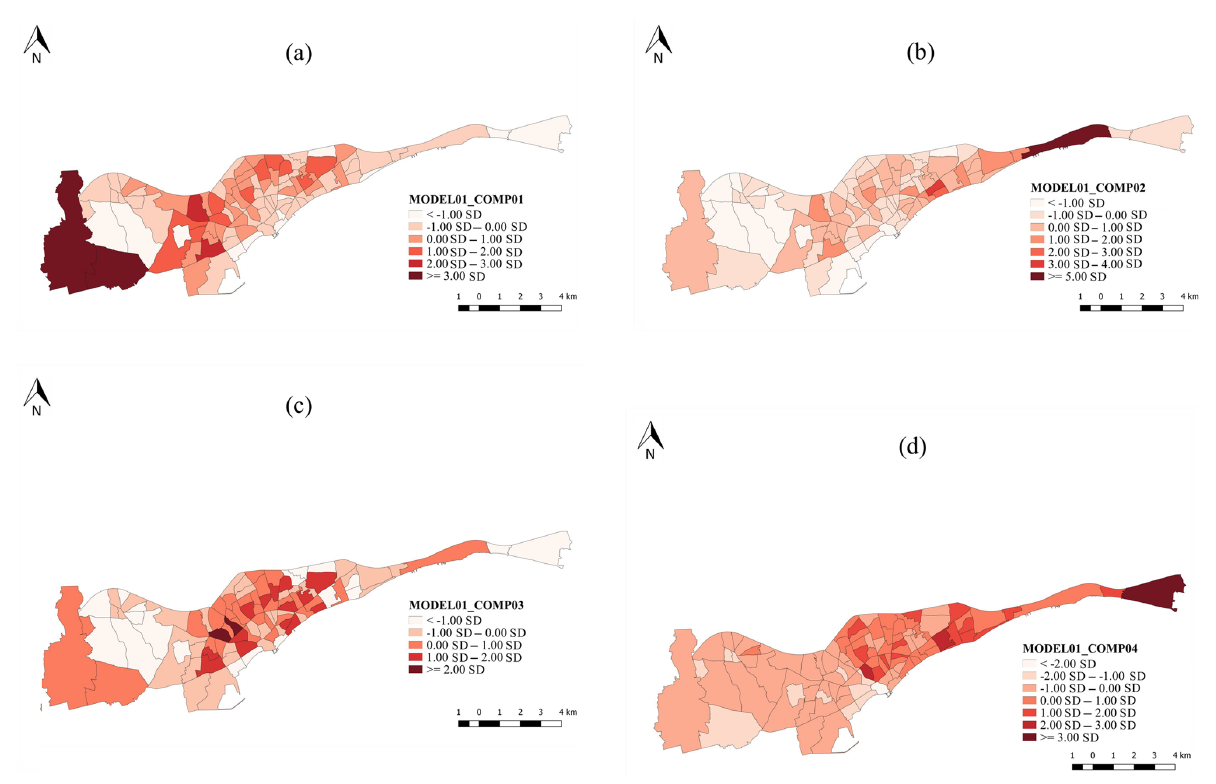
Figure 9. Spatial distribution of Model 1 (coastal and inland area) Components. (a) Component 1; (b) Component 2; (c) Component 3; (d) Component